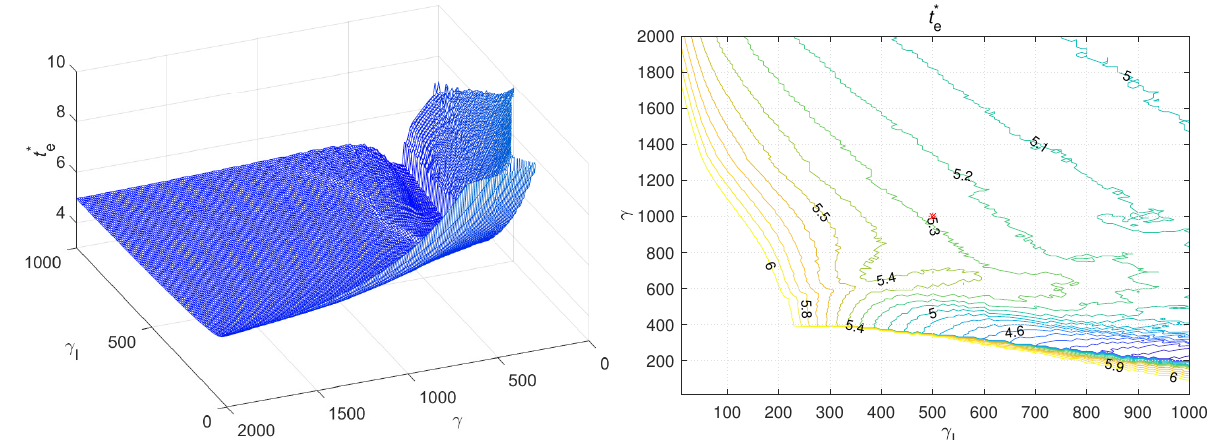
Figure 17. Simulations results. Dependence of t ∗ e on controller gains γ , γ i for “nominal” plant parameters; ω ∗ = 60 rad/s, ψ ∗ = π . Left : 3D plot, right : contour plot; asterisk (cid:63) is for γ = 1000, γ I = 500.